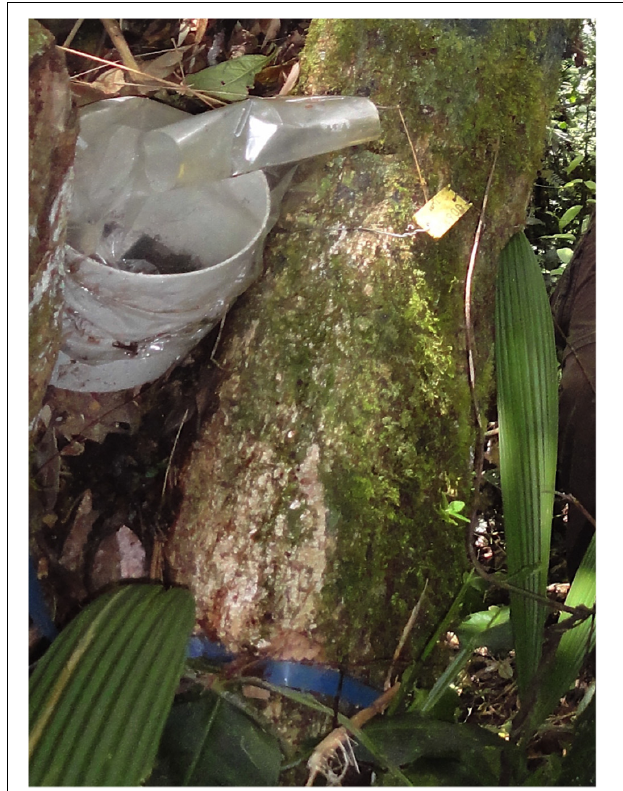
FIGURE 2 | Set-up of a seedling-trap system on a tree